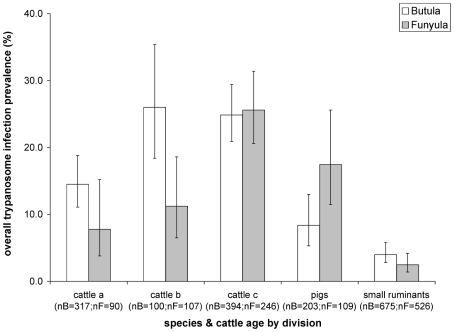
Overall trypanosomiasis prevalence by species and cattle age and division.Cattle a  =  cattle under 18 months, cattle b  =  cattle between 18 and 36 months, cattle c  =  cattle over 36 months; nB  =  number of samples from Butula site, nF  =  number of samples from Funyula site, error bars represent exact binomial 95% confidence interval.